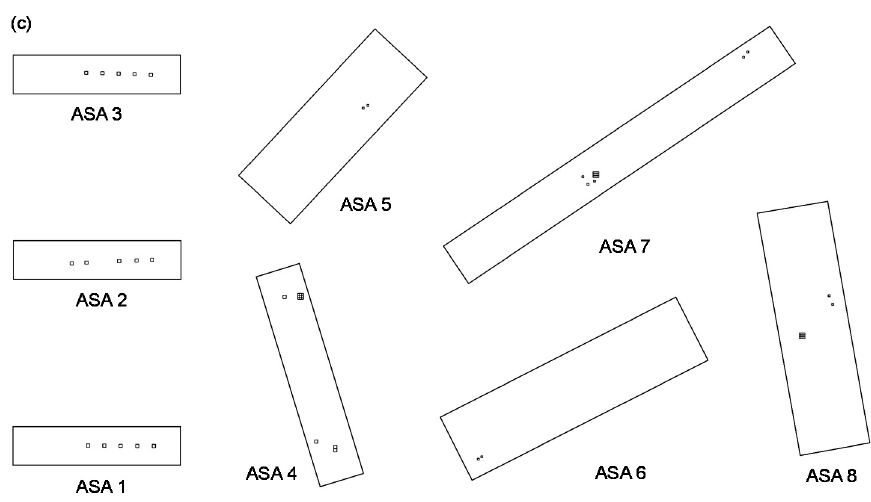
Figure 1. ( a ) The location of the study area in Cambodia (dark areas), ( b ) the coverage by the Quickbird images and the locations of the aerial survey areas within them (ASA 1 to 8, airborne LiDAR and aerial photographs), and ( c ) the relative sizes and shapes of the sample plots.